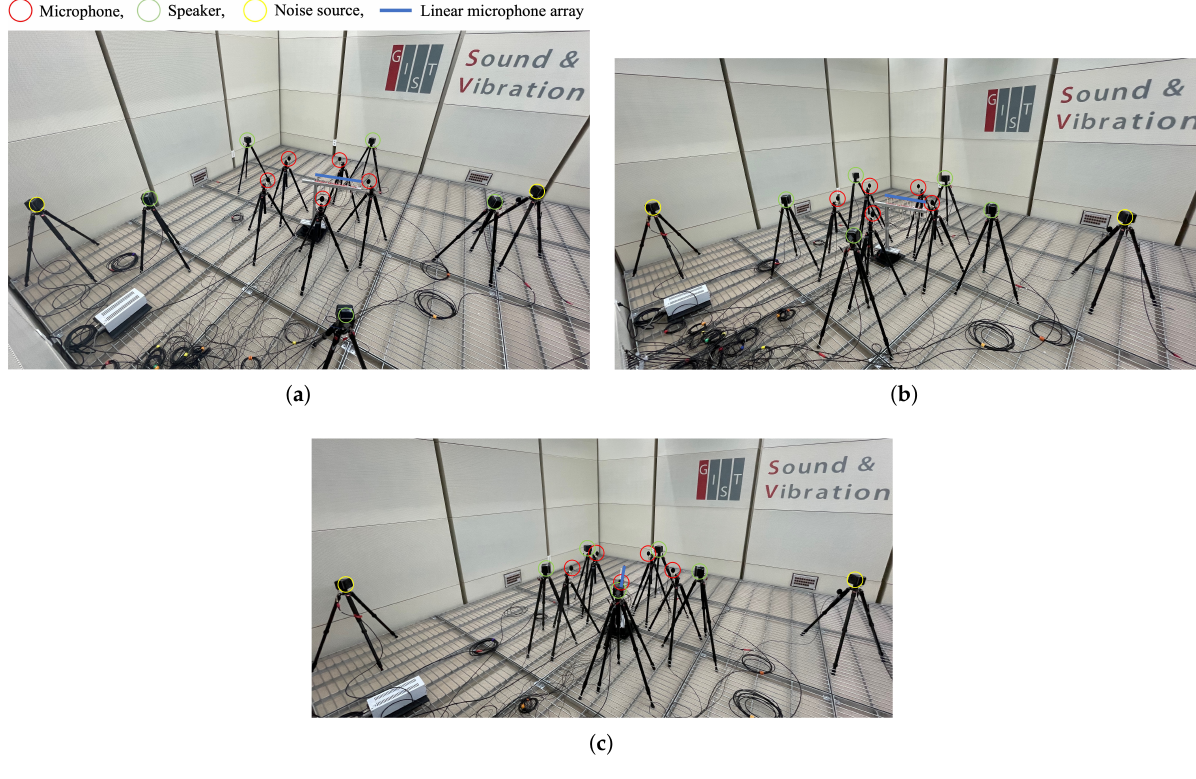
Figure 11. Experimental setup, ( a – c ) cases